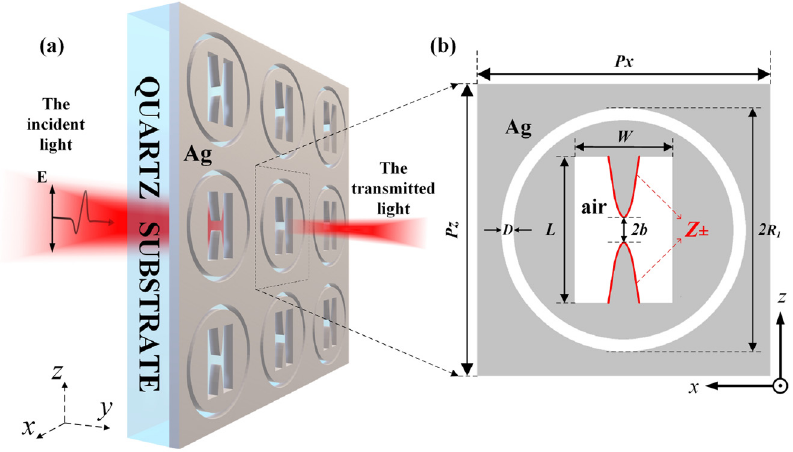
Figure 1: (a) Schematicdiagramof the hybrid metasurface, which is a metallic silver(Ag) film deposited ona quartz substrate, with a periodic hole array of concentric parabolic-hole (PH) and circular-ring-aperture (CRA) unit cells. The incident pulsed light field of linear polarization propagatingin the positive Y -direction actsvertically onthe Ag fi lm from thequartz substrateside. (b)The cross-sectional viewof theunit cell inthe X – Z plane. P x and P z representthearrayperiodsinthe X -andZ-directions,respectively. R 1 and D aretheouterradiusandwidthoftheCRA structure, while L and W represent the length and width of the PH structure, respectively. The edges of the parabolic metal (red curves) follow the quadratic function expressed as Z ± = ± a p x 2 ± b p , where a p and b p are the coef fi cients of the